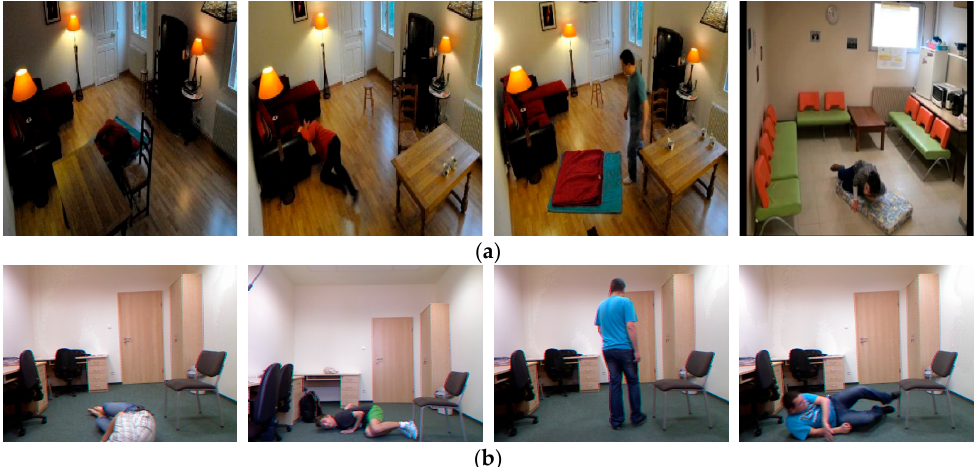
Figure 1. Some example video frames from the publicly available datasets ( a ) Le2i and ( b ) URFD Figure 1. dataset.